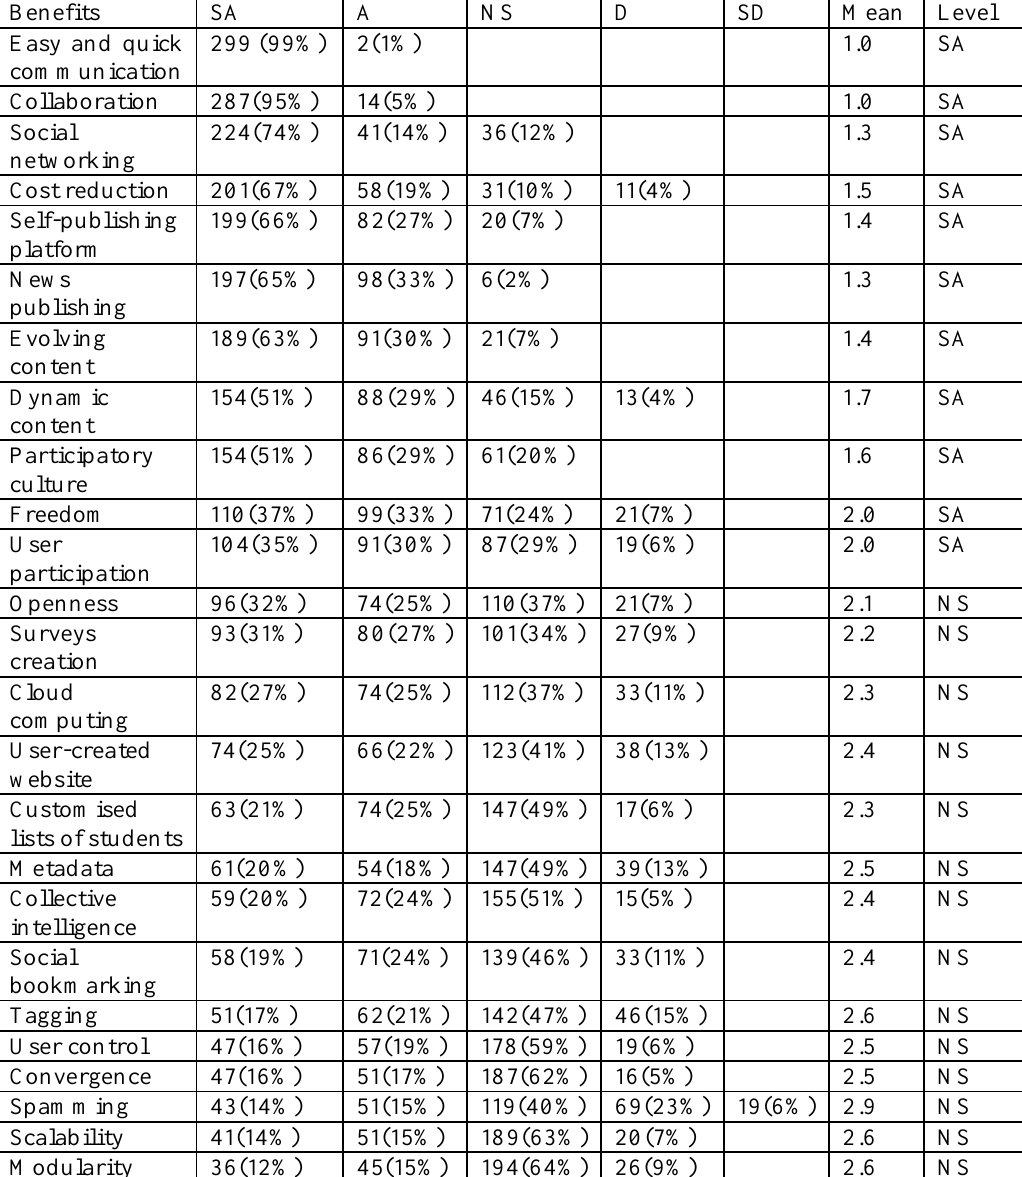
Web 2.0 Benefits In an ODL Institution (N =